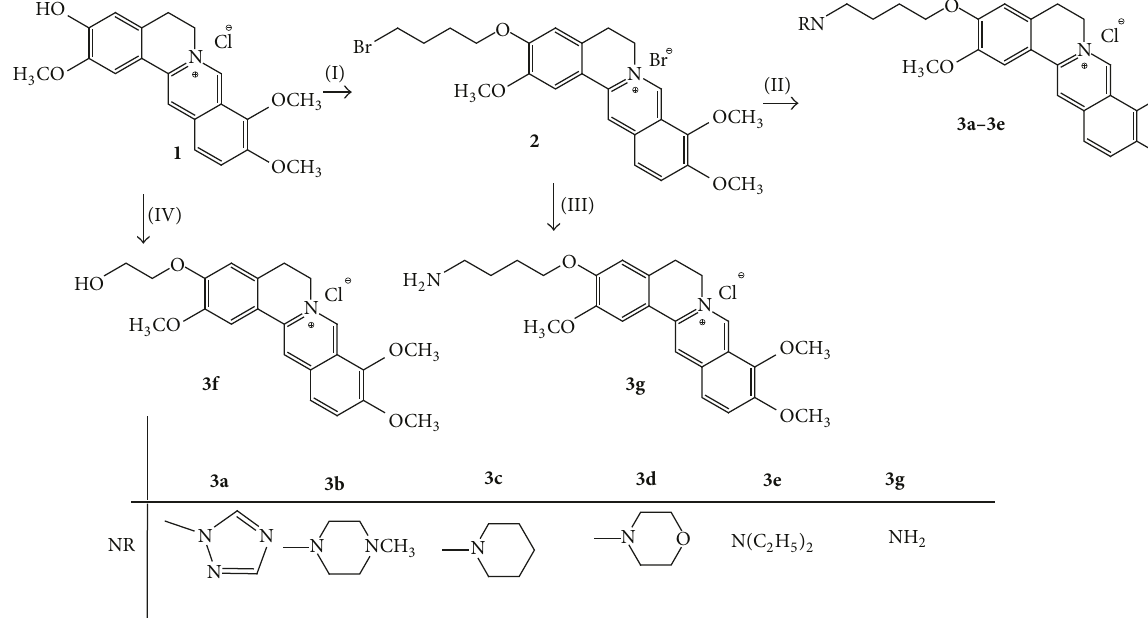
Figure 1: Synthetic route of 3-substituted jatrorrhizine derivatives (3a–3g)